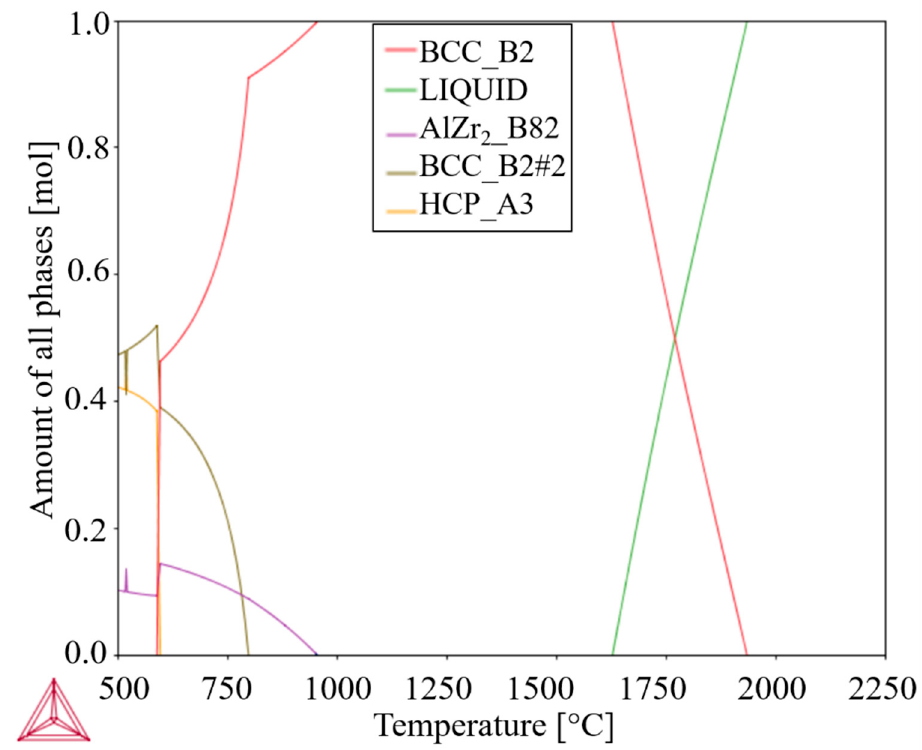
Figure 1. Computed phase diagram for Al 0.3 NbTa 0.8 Ti 1.5 V 0.2 Zr RHEA according to CALPHAD calculations using ThermoCalc software, as the amount of all phases vs. temperature (for interpretation of the references to color in this figure legend, the reader is referred to the web version of this article).